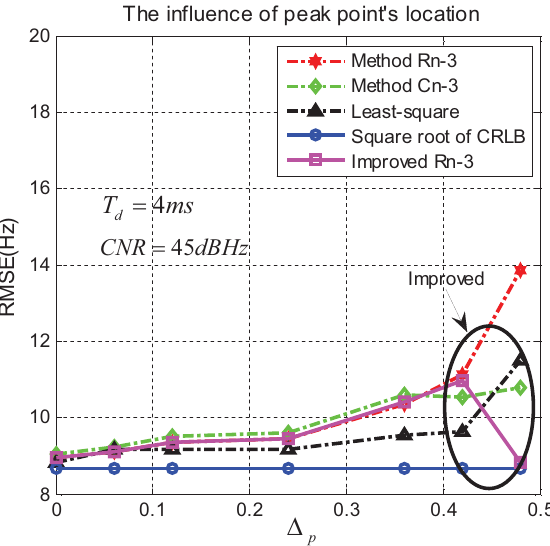
Figure 12. Influence of the quantization error on the RMSE as a function Δ p .